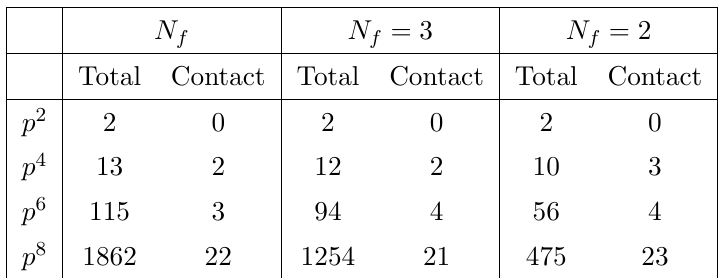
Table 3 . Number of monomials in the minimal basis for the case with all external (cid:12)elds included. Also listed is how many of them are contact terms. Our results agree with the known ones for p 2 , p 4 , p 6